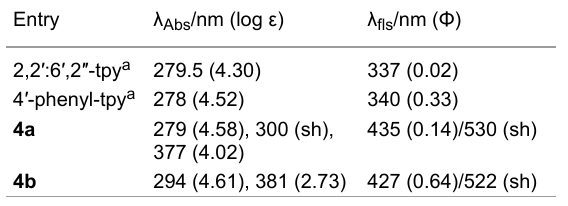
Table 3: Absorption and fluorescence maxima of 2,2 ′ :6 ′ ,2 ″ -terpyridine (tpy) derivatives in dichloromethane at room temperature.